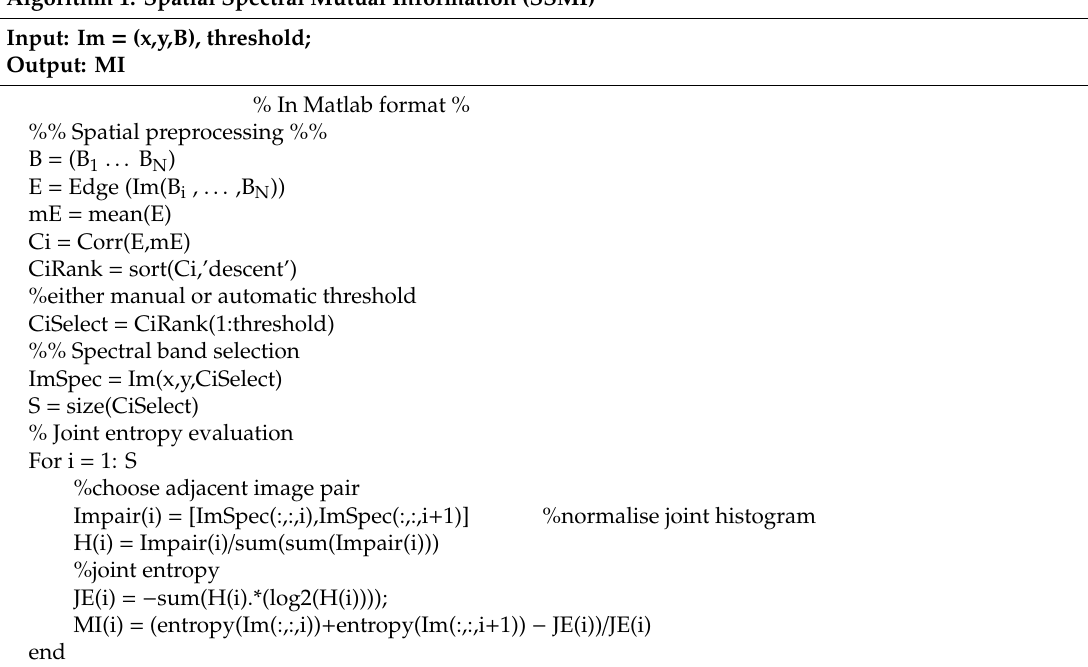
Table 1. Pseudo-code of the proposed spatial spectral mutual information (SSMI) method. Algorithm 1: Spatial Spectral Mutual Information